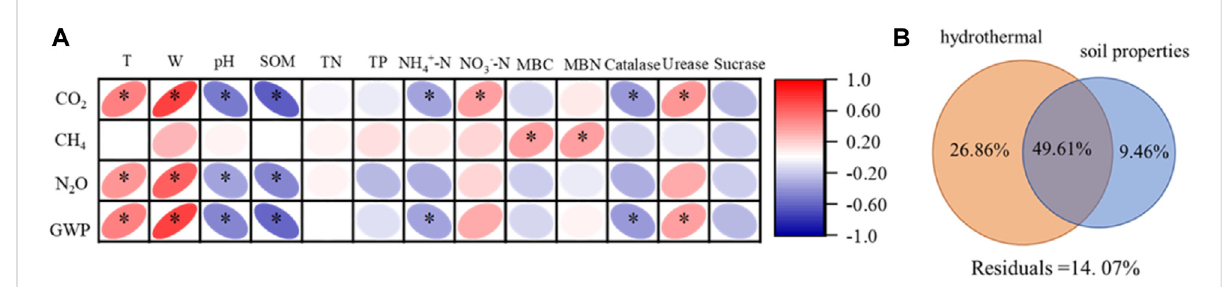
FIGURE 4 Pearson correlation analysis (A) . The red and blue ellipses represent positive and negative correlations between GHG emissions and soil properties,respectively.Thedarkerthecolourandthe fl atterthegraphare,thestrongerthecorrelationis,and*representssigni fi cance( p < 0.05). (B) The variance decomposition analysis of global warming potential (GWP) in fl uenced by soil hydrothermal factors and soil properties, in which the overlap represents the common in fl uence and the residual represents the unexplained variation. T: temperature; W: moisture; SOM: soil organic matter; TN: total nitrogen; TP: total phosphorus; MBC: microbial biomass carbon; MBN: microbial biomass nitrogen; NH 4 + -N: ammonium nitrogen; NO 3 − -N: nitrate nitrogen, same as Table